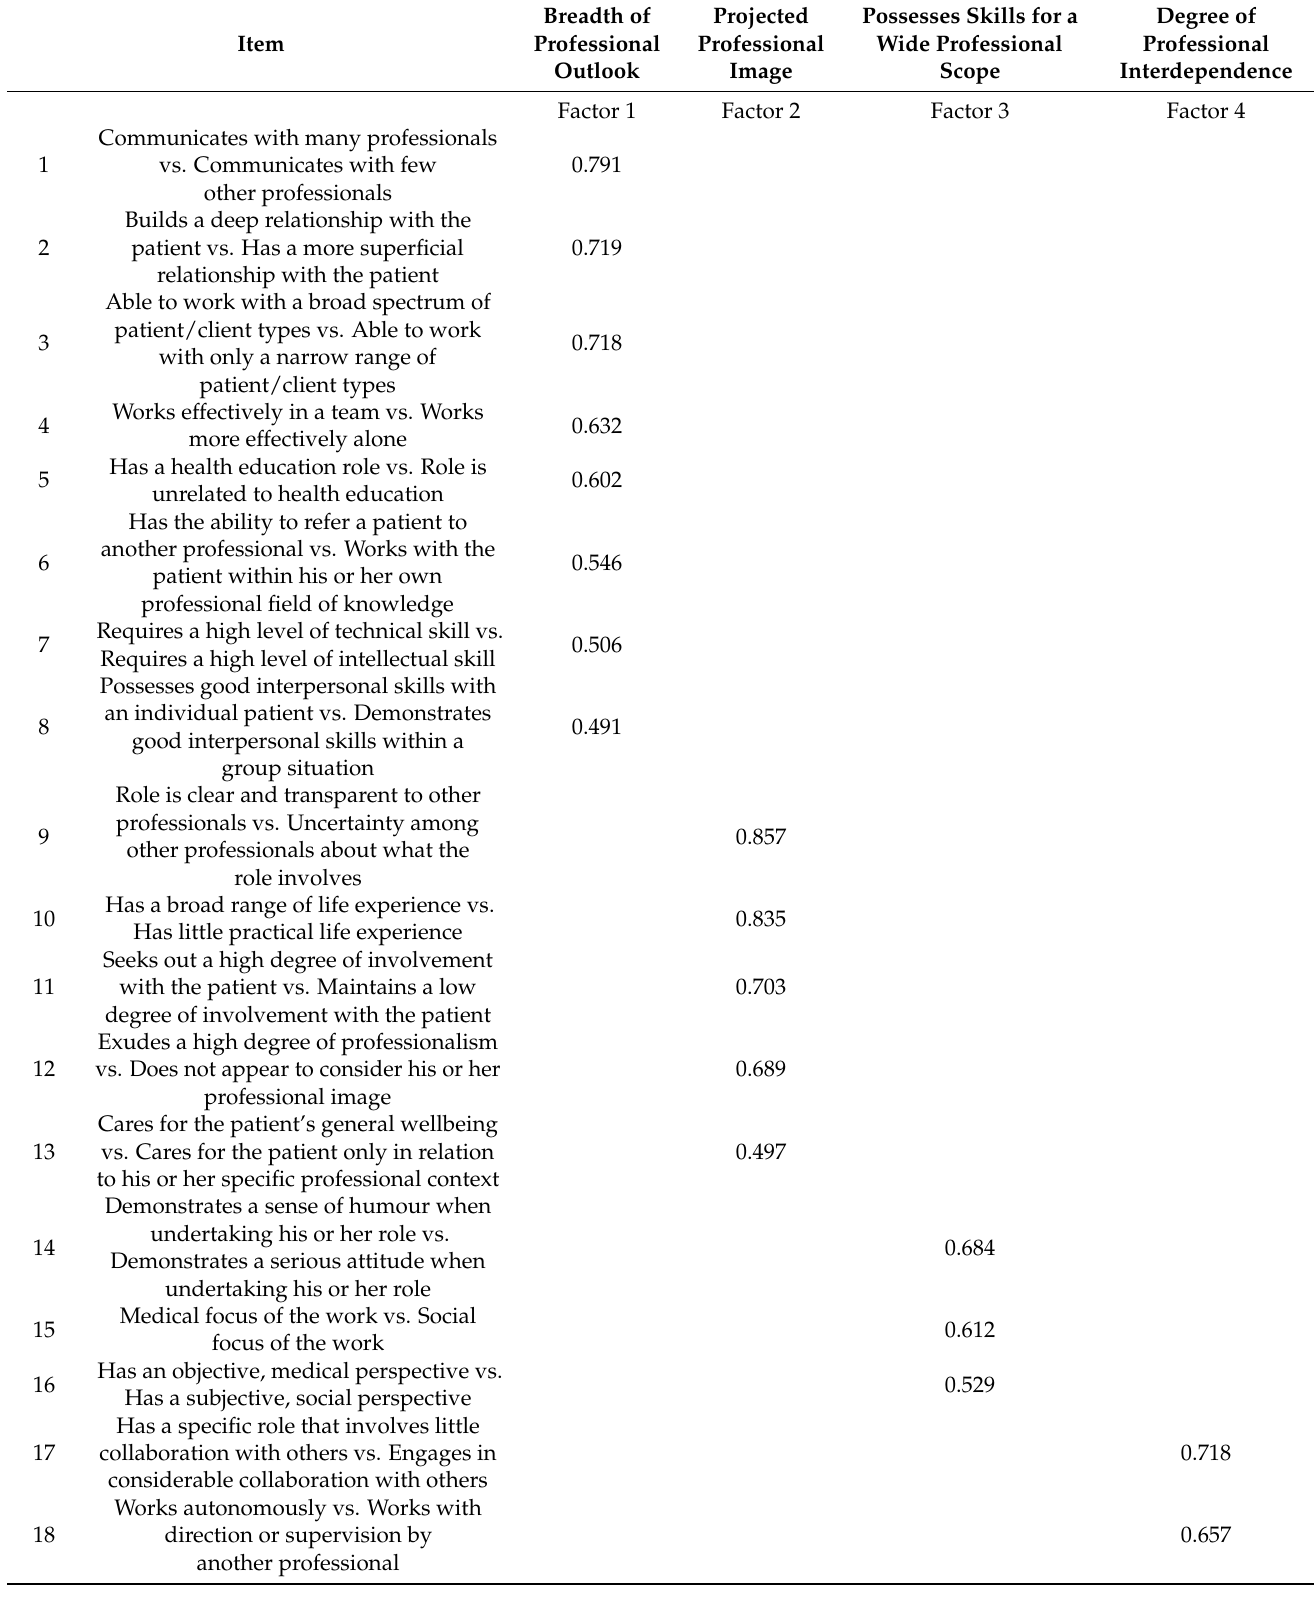
Table 2. Factor analysis of medical students’ perceptions of the role of